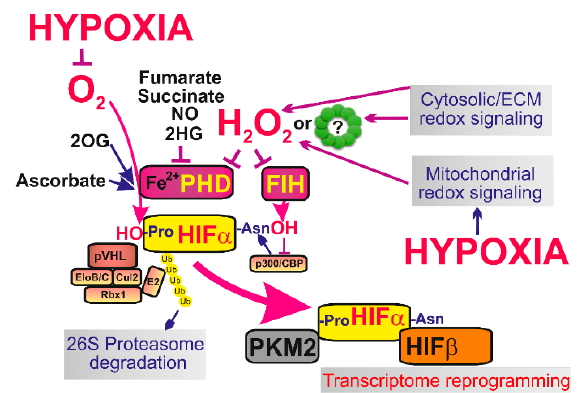
Figure 3. The major mechanisms of initiation of HIF-mediated transcriptome reprogramming—At normoxia isofoms of hypoxia-inducible factor α (HIF- α ), such as HIF-1 α are constantly degraded which is ensured by ubiquitin ligase Von Hippel-Lindau tumor suppressor protein (pVHL) and the components of the proteasome complex e.g., elongin B / C (EloB / C), cullin 2 (Cul2), ring-H2 finger protein (Rbx1) or ubiquitin ligase E2. During hypoxic adaptation the lack of oxygen and mitochondrial redox signaling (or in some situations also elevation of cytosolic ROS) lead to stabilization of HIF- α and it’s binding to HIF- β . As a result stabilized HIF with the help of transcription factor p300 / CBP causes transcriptome reprogramming (up to 400 genes are a ff ected) and a typical metabolic switch to Warburg phenotype, when OXPHOS is suppressed while glycolysis and lactate production is upregulated. The link between low oxygen levels and mitochondrial redox signaling is provided and in fact integrated by the resulting inactivation of prolyl hydroxylases (PHDs) and factor inhibiting HIF (FIH), which no longer are able to hydroxylate HIF α and cause it’s degradation. Pyruvate kinase isozyme M2 (PKM2) migrates to nucleus to specifically enhance